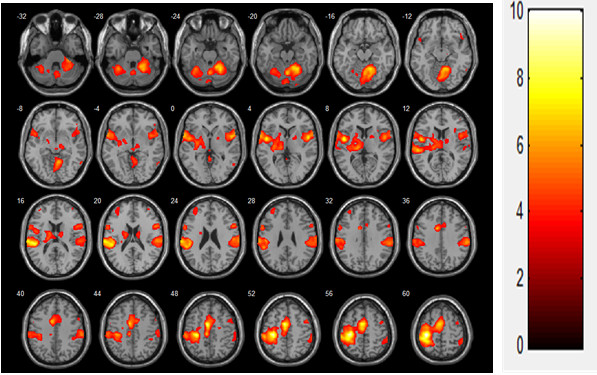
 Voluntary contraction (N = 19, t(18) > 3.141, FDR < 0.05).